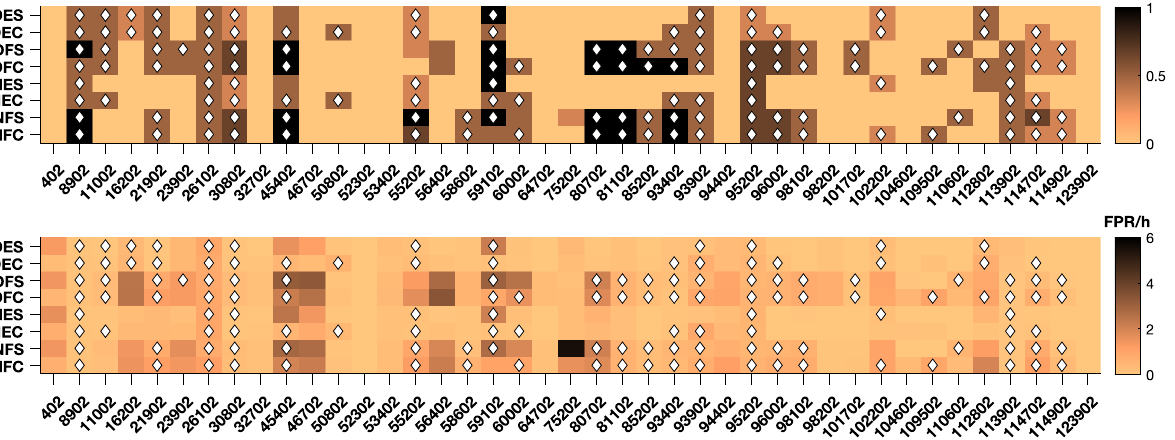
Figure 4. Results for each patient for DES (Denoised EEG Standard ), DEC (Denoised EEG Chronological ), DFS (Denoised Features Standard ), DFC (Denoised Features Chronological ), NES (Noisy EEG Standard ), NEC (Noisy EEG Chronological ), NFS (Noisy Features Standard ), and NFC (Noisy Features Chronological ) approaches. The top subfigure presents the seizure sensitivity obtained for each patient-specific model, while the bottom figure shows the FPR/h. The diamond symbol indicates that the model performed above chance level. The scales of the colours are on the right side of the subfigures.